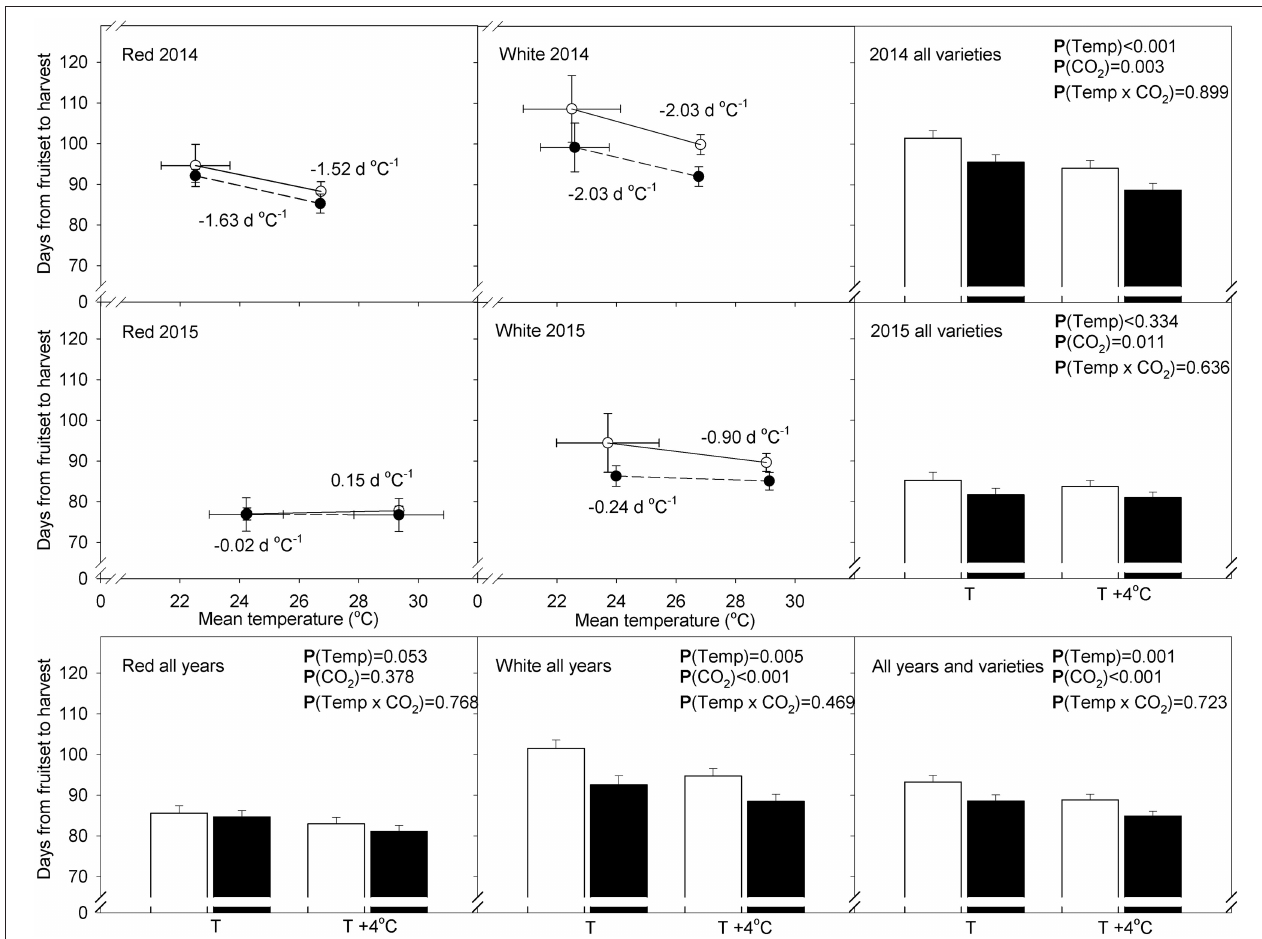
FIGURE 5 | Days to complete fruit development (from fruit set to designated maturity) vs. mean temperature between the phenophases in ‘Red Tempranillo’ and ‘White Tempranillo’ grapevine grown under two CO 2 concentrations (ambient CO 2 or 700 µ L L − 1 CO 2 ; white and black points and bars, respectively) and two temperature regimes (ambient temperature, T or ambient temperature + 4 ◦ C, T + 4 ◦ C). Points and bars represent means ± standard error ( n = 16–20). P -values based on four-way ANOVA taking as main factors: cultivar, temperature, CO 2 concentration and water availability.